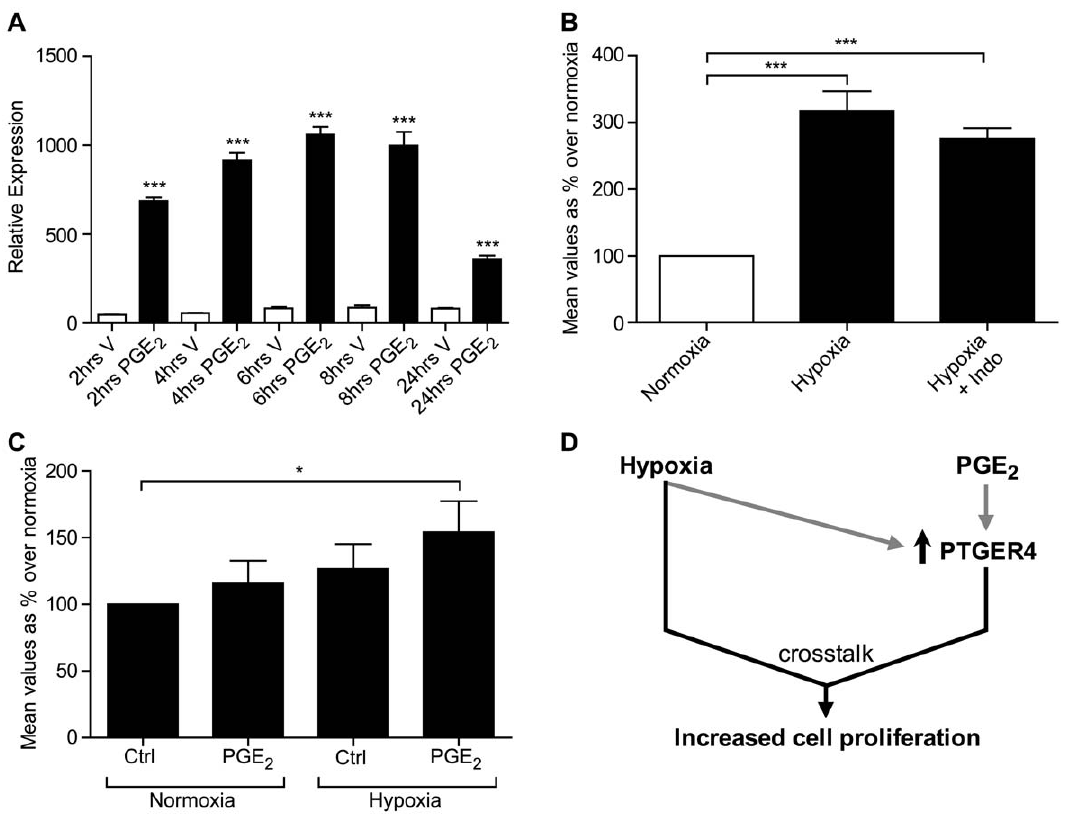
Figure 6. Mechanism of regulation of cellular proliferation in PTGER4 cells in vitro. ( A ) PTGER4 mRNA expression in PTGER4 cells treated with vehicle or 100 nM PGE 2 for 2, 4, 6, 8 and 24 hours (n=3). ( B ) PTGER4 expression in PTGER4 cells grown for 24 hours under normoxic and hypoxic conditions, in the absence or presence of the PTGS enzyme inhibitor indomethacin (n=4). ( C ) Cellular proliferation in PTGER4 cells grown for 24 hours under normoxic (N) or hypoxic (H) conditions in the absence or presence of 1 m M PGE 2 (n=4). ( D ) Schematic diagram of findings demonstrating that hypoxia and PGE 2 both independently elevate PTGER4 expression and synergise to enhance proliferation of PTGER4 cells. *, *** represent significance at P , 0.05 and P , 0.001 respectively.